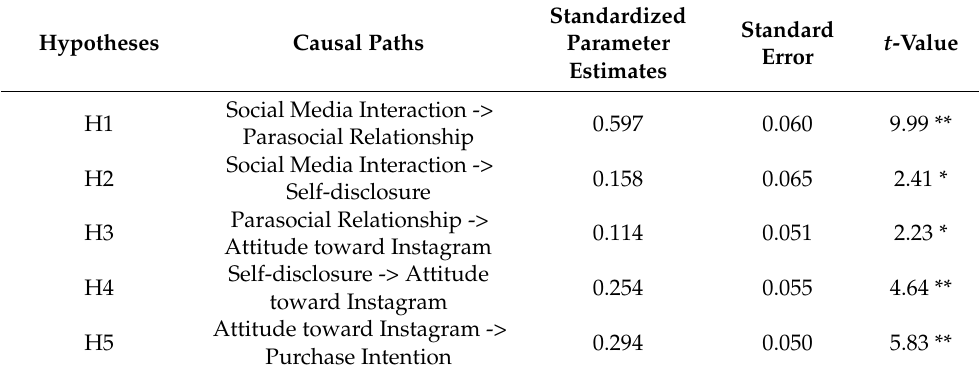
Figure 1. Structural Equation Model for Relationships of Parasocial Interaction to Perceived Ad Message Authenticity, Match-Up, and Purchase Intention. Table 2. Parameter estimates for causal